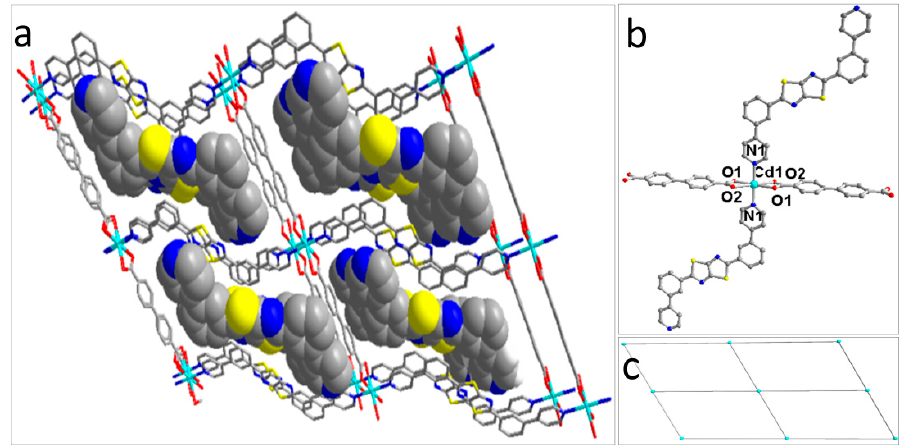
Figure 1. The 3D network of 1 ( a ), the coordination environment of Cd(II) in 1 ( b ), and the topological network formed in 1 ( c ).